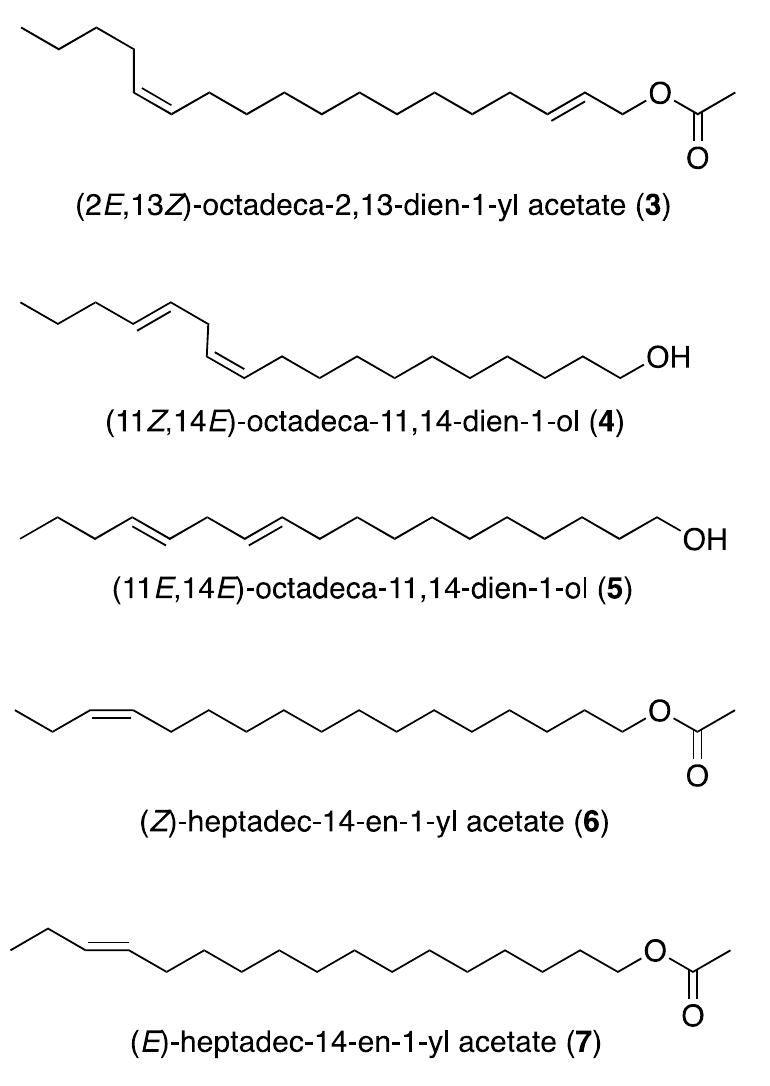
Figure 2. Structures of (E)-2-(Z)-13-octadecadien-1-ol acetate [56], (Z,E)- and (E,E)-11,14-octadecadienal [57] and (Z)- and (E)-heptadec-14-en-1-yl acetate [58]. All compounds were synthesized with alkyne zipper reaction as part of the synthesis. Mori also used the alkyne zipper reaction in the synthesis of sex pheromone mimics 8 and 9 against the yellow peach moth [59]. In this synthesis, the resulting terminal alkyne was alkylated, followed by reduction of the alkyne to E - and Z -alkenes using lithium tetrahydridoaluminate or Lindlar catalyst and hydrogen, respectively. These were transformed into the corresponding formats, see Scheme 8. Bioassay of a 10:1 mixture of E and Z against the male Dichocrocis punctiferalis demonstrated it to be as active as the natural product in low dose experiment. However, the natural pheromone was more active at higher dose